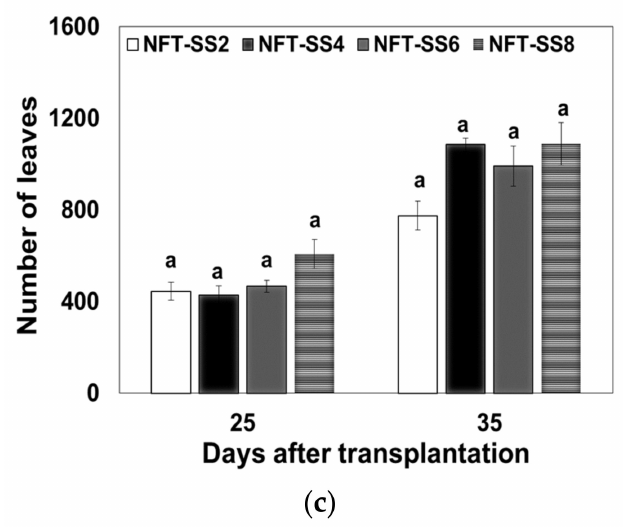
Figure 4. Mean number of leaves of basil irrigated by means of a ( a ) G-NS or ( b ) G-SS during the first period and ( c ) NFT-SS during the second period. Means followed by different lowercase letters (a, b, c) differ significantly according to the Tukey–Kramer HSD test at p < 0.05 across the fertigation